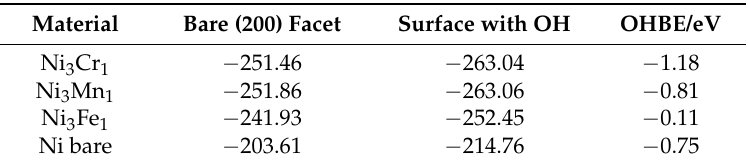
Table A5. Ground state energies of bare and with OH at (200) facet (1/8 ML) supercell 2 × 2 × 1 and calculated OHBE (all energies are in eVs).